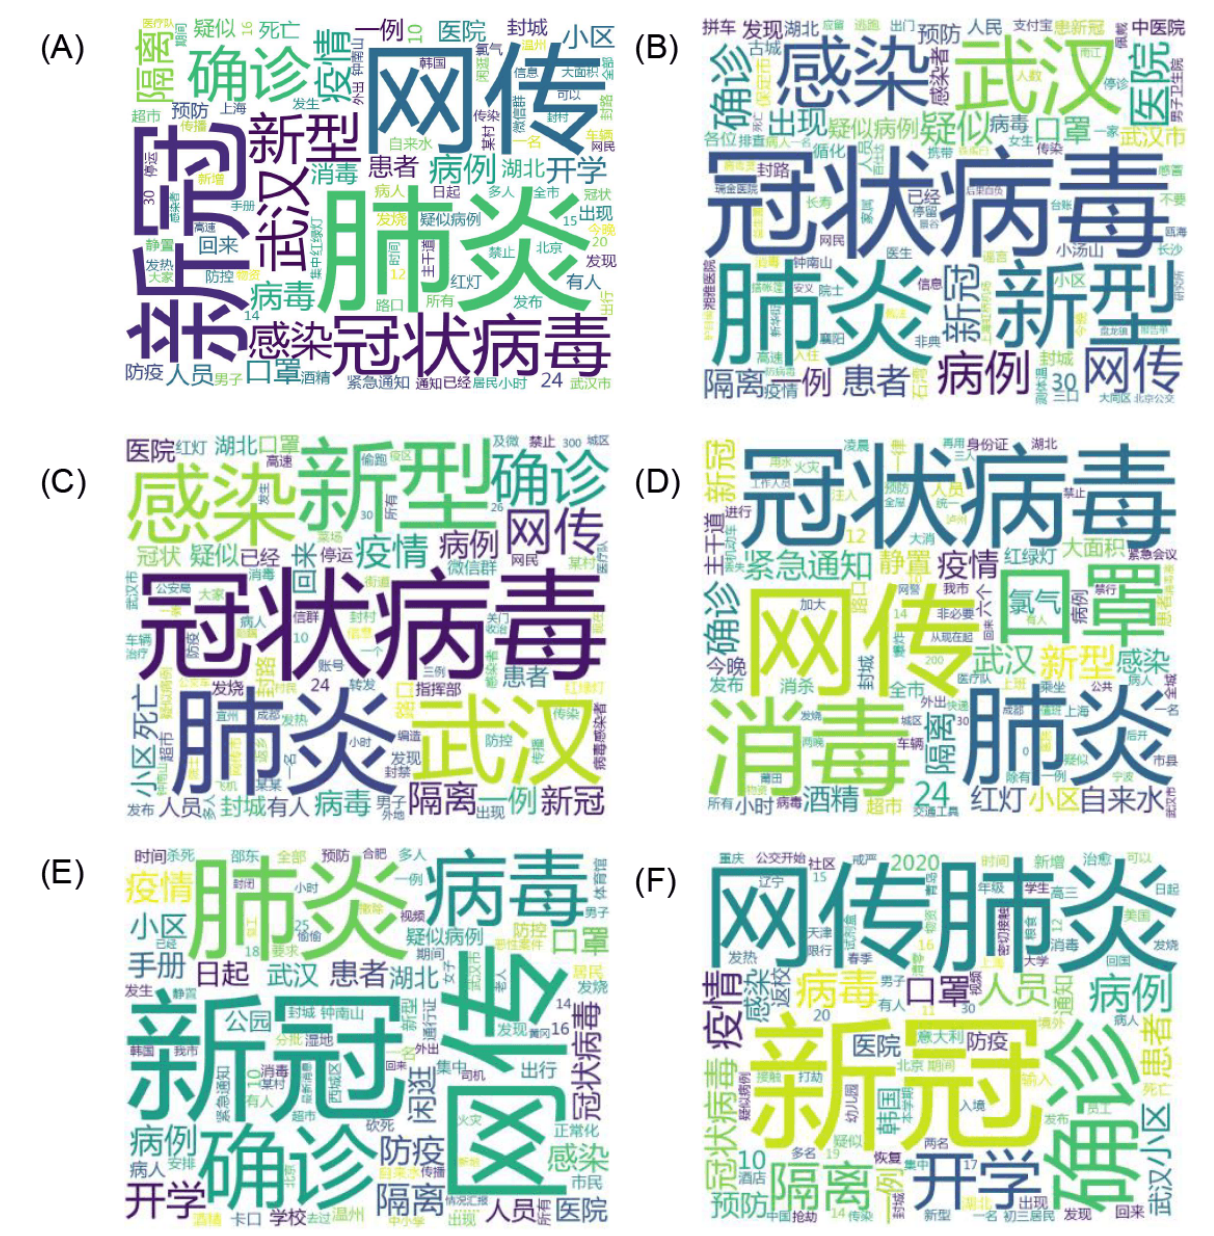
Figure 5. The top 100 most frequent words in the core messages of rumors during the outbreak of COVID-19 in China: (A) during the whole study period, (B) from January 20-24, 2020, (C) from January 25 to February 4, 2020, (D) from February 5-12, 2020, (E) February 13-26, 2020, and (F) from February 27 to April 8,